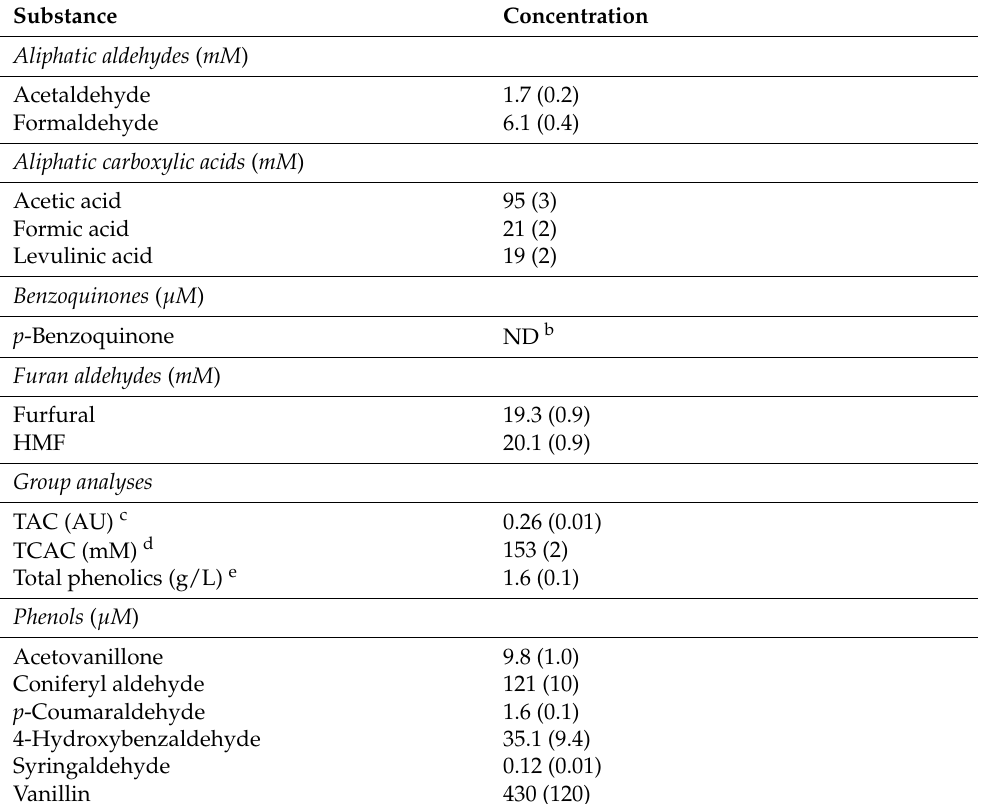
Table 2. Concentration of bioconversion inhibitors in pretreatment liquid a